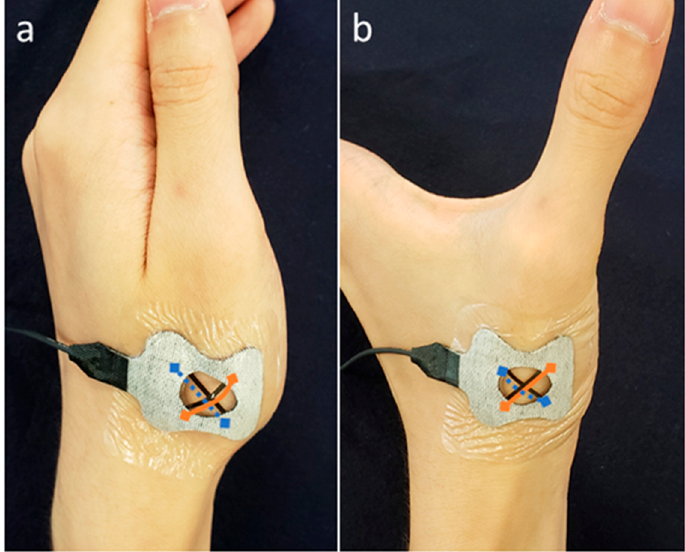
Figure 3. ( a ) In the adduction position, Sensor 1 (orange line) was slack and Sensor 2 (blue broken line) was taut, while to the contrary, ( b ) in the palmar abduction position, Sensor 1 was taut and Sensor 2 was slack.